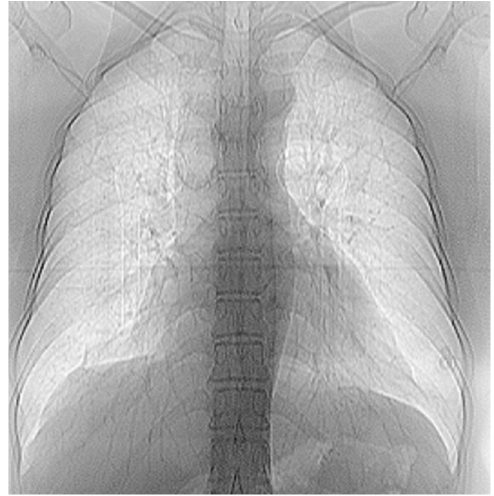
Figure 13. The image from Figure 12 in “Invert color” format.